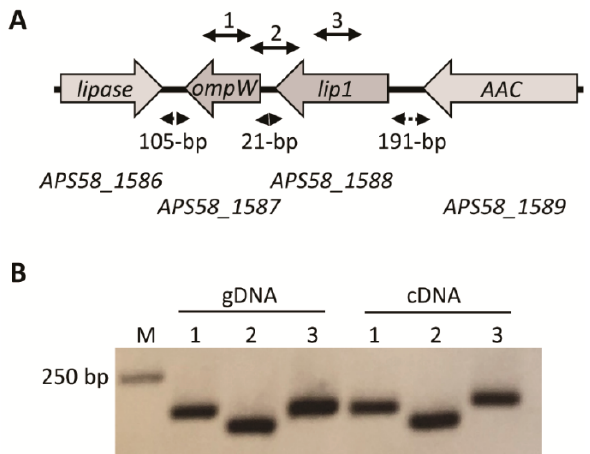
Figure 1. The lip1-ompW operon. ( A ) Schematic organization of the operon and neighboring genes according to the annotation of the Acidovorax citrulli M6 genome (GenBank accession CP029373.1). Grey arrows represent the open reading frames (ORFs) and transcription direction of the following genes (numbers between parentheses indicate the position of start and stop codons in the A. citrulli M6 chromosome): APS58_1586 , hypothetical protein but having high similarity to GDSL lipases